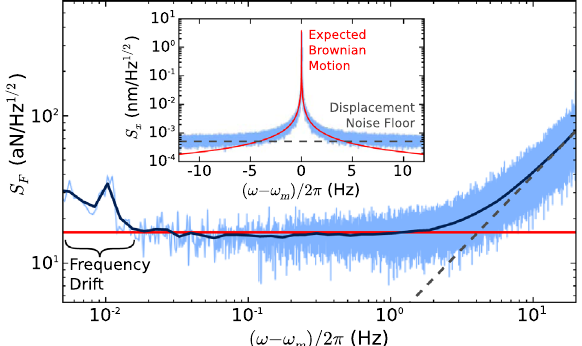
FIG. 3. Force noise measurement for the s 1 mode of a 44-nm- thick trampoline. The inset shows the displacement noise spectrum S x; (blue) observed for a laser power of 50 μ W, obs along with the spectrum expected for the measured device parameters S x (red) and the displacement noise floor of the interferometer (dashed line, 509 (cid:2) 44 pm = Hz 1 = 2 ). The main ¼ S S =S panel shows the force noise spectrum S F; x; obs F x (blue), obs consistent (within a about 5% systematic calibration error) with the expected 16 . 2 (cid:2) 0 . 8 aN = Hz 1 = 2 (red) over many thousands of linewidths. The dark blue line is the same data “ coarsened ” by FIG. 4. Optical properties of fabricated nitride. (a) Schematic. averaging together points within 10% of each other. The dashed An extended membrane or trampoline resonator is positioned near line again indicates the displacement noise floor. the waist of a Fabry-Pérot cavity. Input mirror reflectivity j r i j 2 ≈ j 2 > 0 . 999993 . (b) After 0 . 9997 and “ backstop ” reflectivity j r b passing through resonance, interference between the light leaving the cavity and the light promptly reflected from the input mirror produces beating of the form ae − t= 2 τ c cos ½ð ω 0 þ bt Þ t þ c (cid:3) for fit (red curve) parameters a , ω 0 , b , c , and power ringdown time τ c ¼ 1 . 00 (cid:2) 0 . 05 μ s (finesse F ¼ 20 ; 100 (cid:2) 1 ; 000 , the error repre- sents statistical fluctuations of multiple measurements). (c, upper) Finesse and cavity-mode detuning versus the displacement of an extended membrane. White curves show the fit (see text),and solid dashed lines show the approximate empty-cavity resonance frequencies. The inset shows a qualitative sketch of left and right cavity modes. (c, lower) Comparison of finesse (from the topmost resonance) with prediction for a lossless membrane(red). (d)Same as (c) but for a patterned trampoline of width d ¼ 200 μ m — in this case, the trampoline ’ s effective reflectivity is j r t j ¼ 0 . 31 (cid:2) 0 . 01 . The inset shows a qualitative sketch of the cavity cross section at the